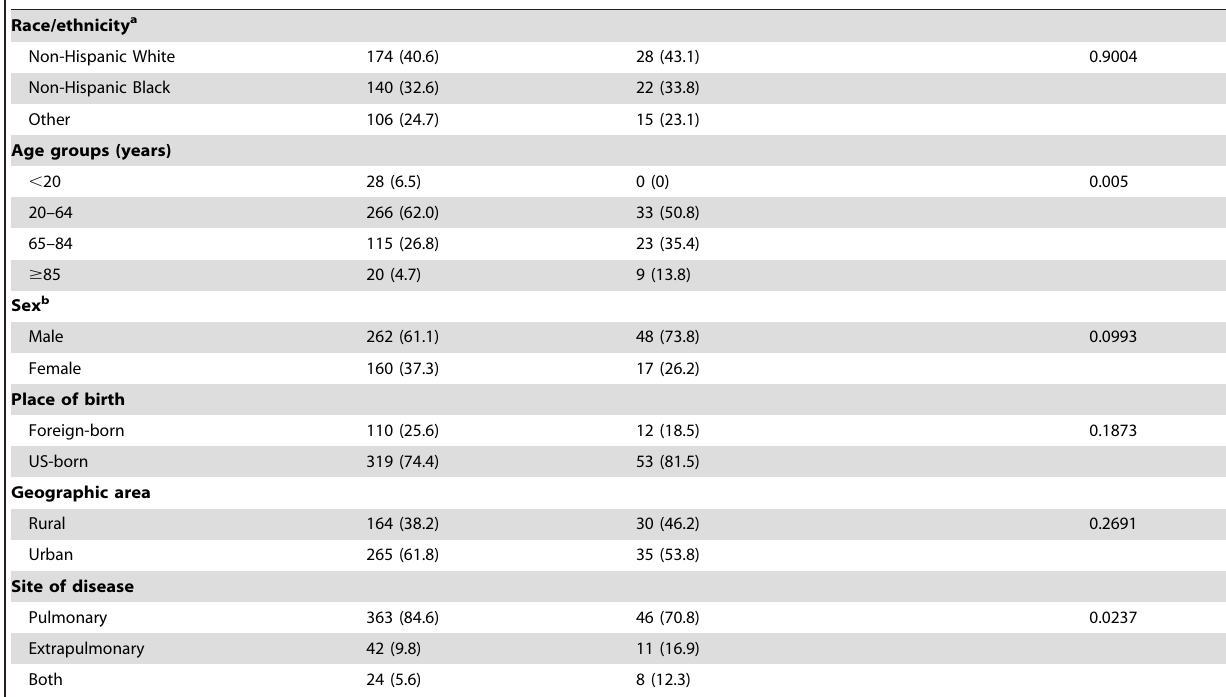
Table 2. Comparison of Distribution of Selected Demographic and Clinical Characteristics among the 429 Genotyped Tuberculosis Cases Included in the Study Sample with that among the 65 Culture-Confirmed Tuberculosis Cases Excluded from the Study due to Lack of Genotyping Information.